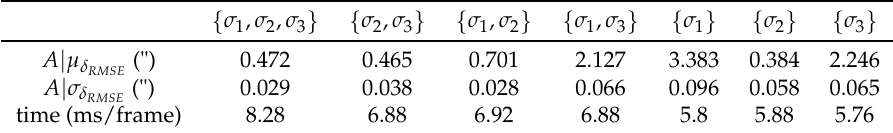
Table 3. Calibration results by different singular value combinations.